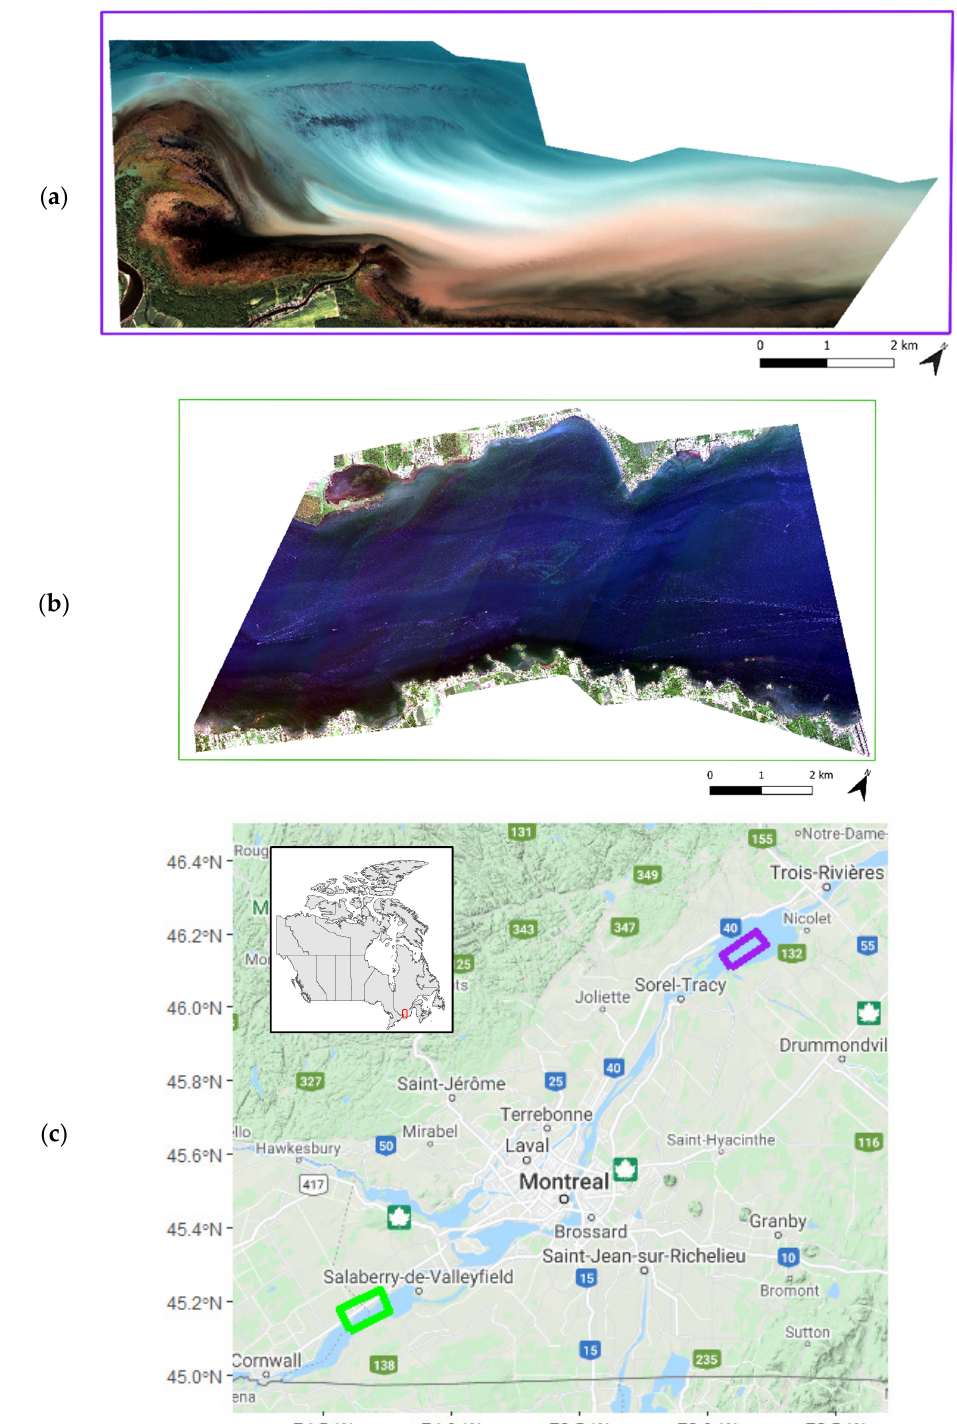
Figure 3. Images used in this study and their location. ( a ) Image 1: Quickbird-2 four band imagery of lake Saint-Pierre (© 2022 Maxar Technologies) ( b ) Image 2: Worlview-03 eight band imagery of lake Saint-François (© 2022 Maxar Technologies) ( c ) Location of the two fluvial lakes in southern Quebec, Canada (map data © 2022 Google). Purple is ( a ), green is ( b ) and the red square in the insert shows the location within Canada.